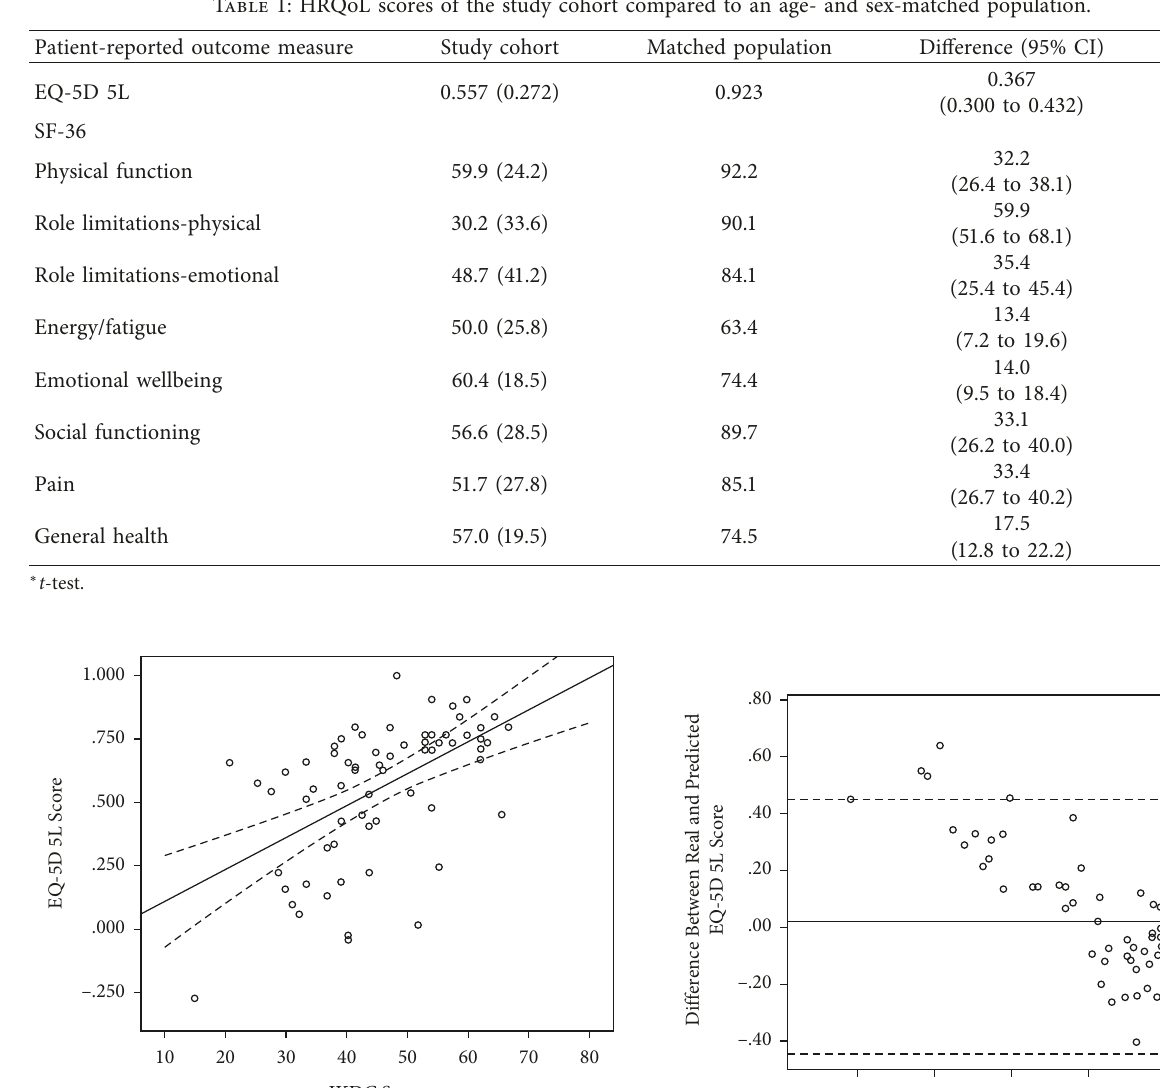
–.250 Figure 2: A Bland and Altman plot for the mean EQ-5D 5L score and the difference between actual and predicted scores. Solid horizontal line in the mean difference and dashed lines are 1.96 standard ∗